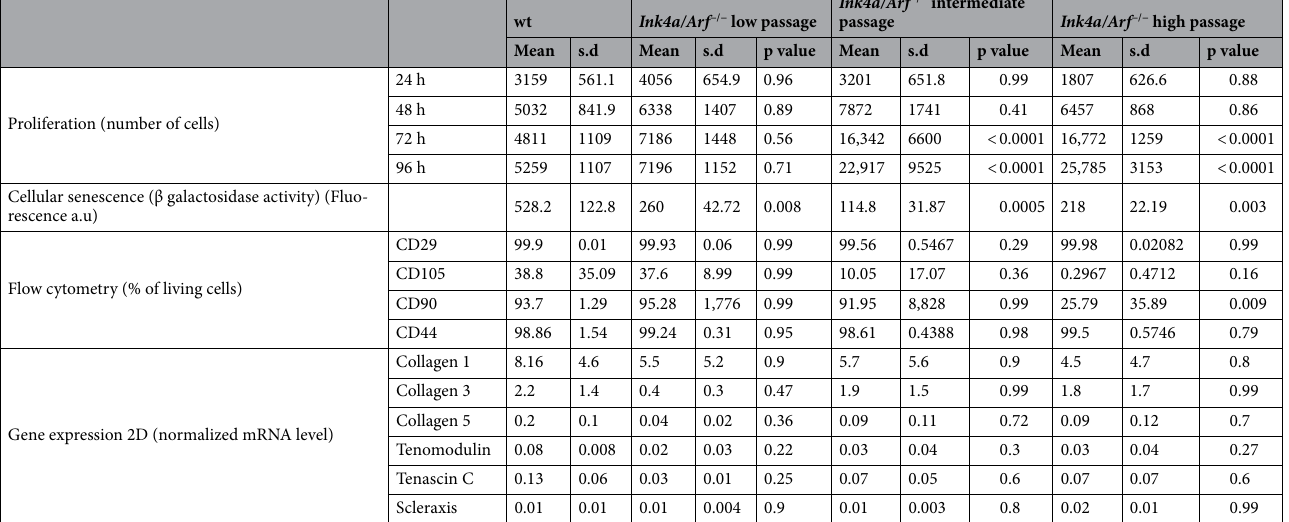
Table 1. Summary of proliferation, senescence (β-galactosidase activity), flow cytometry and qPCR (gene expression) analyses performed in wild-type (wt) and Ink4a/Arf − / − tenocytes. Results are presented as mean ± s.d. Ink4a/Arf − / − cells (in low, intermediate, and high passages) were compared to wt cells using an ANOVA with Tukey’s multiple comparisons test, and the p -value is shown for each evaluation. (a.u.—arbitrary units).